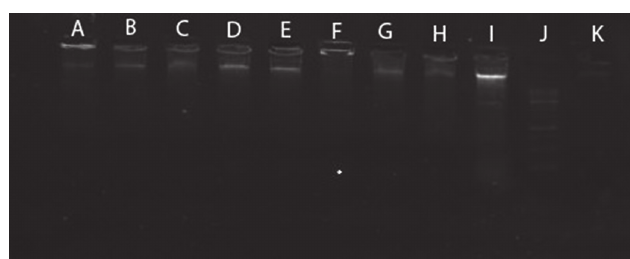
FIGURE 4 - DNA Cleavage of materials; (A): Pelagonium graveolen & Mn‑Ni@Fe O ; (B): Mn-Ni@Fe 3 4 Euphorbia prostrata ; (D): Pelagonium graveolen ; (E): Mn: Fe(OH)3 Nanoparticles; (F): Euphorbia prostrata & Mn: Fe(OH)3 Nanoparticles; (G): Euphorbia prostrata & Mn‑Ni@ Fe O ; (H): Pelagonium graveolen & Mn: Fe(OH)3; (I): DNA; 3 4 (J): Lader; (K): H O 2 2